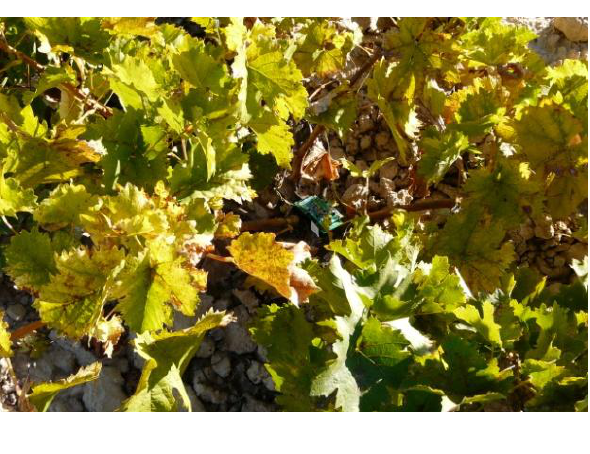
Figure 1. Active node surrounded of dense foliage from the vines.